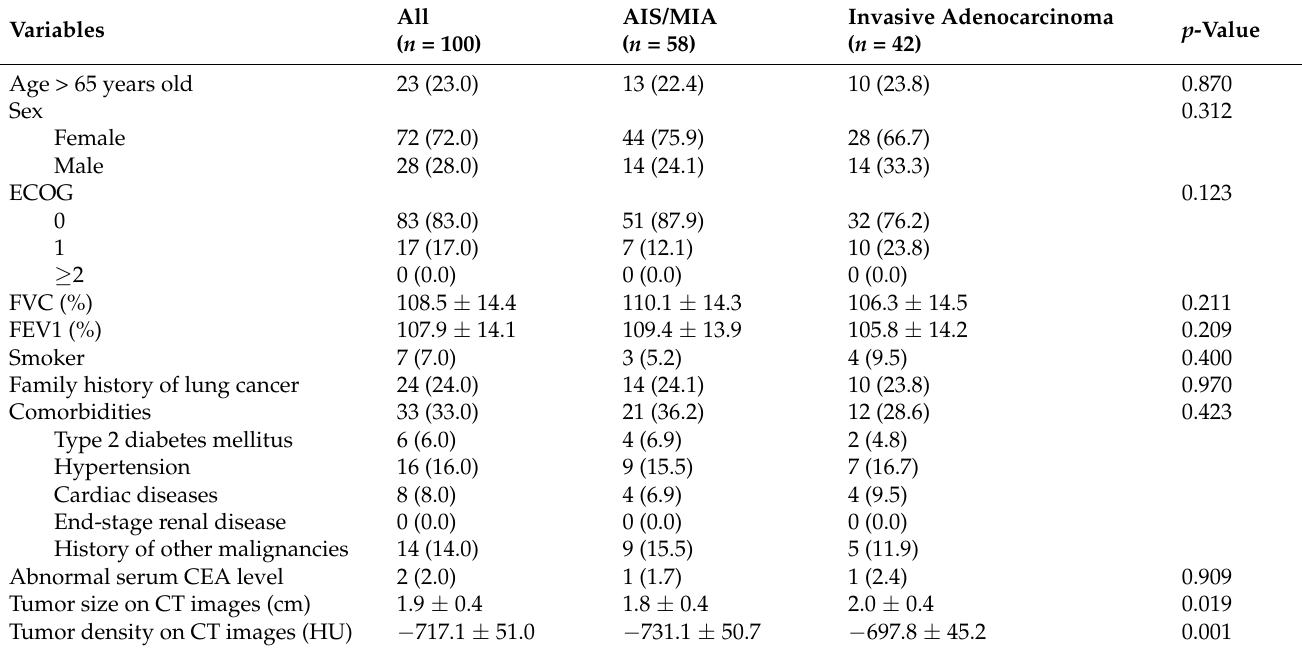
Table 5. Demographic and clinical features of the additional pGGN cohort for external validation.